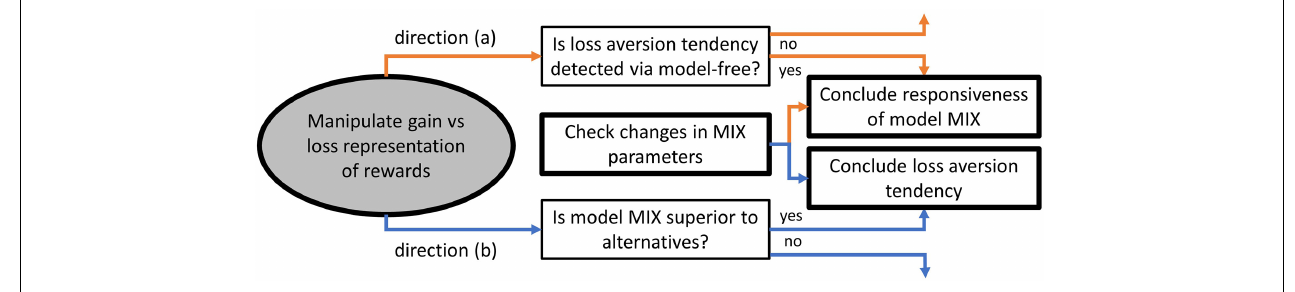
FIGURE 4 | Research directions for the loss aversion as an exemplar behavioral variation compared with choices when outcomes are presented in gain domain. Directions (a) and (b) are presented in orange and blue, respectively.